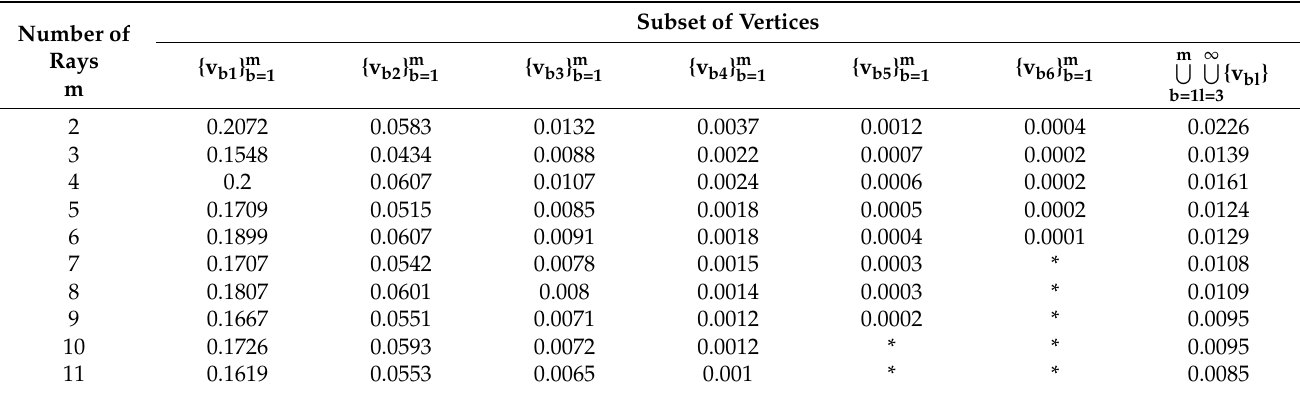
Table 3. Numerical estimates for the relative error of solving the problem of the optimal placement of elements in subsets of the vertices of the attack structure; rounding is to the fourth digit with excess (* is an unreliable value due to